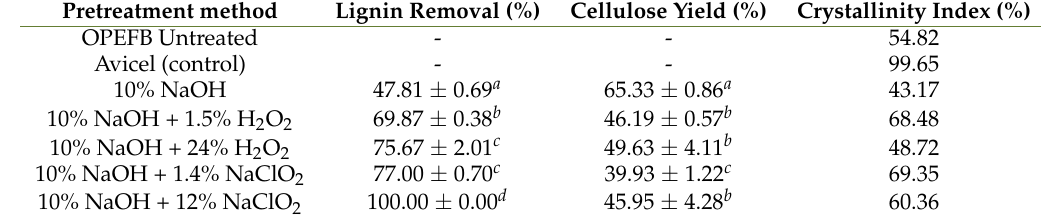
Table 4. The lignin removal, cellulose yield, and crystallinity index of OPEFB after pretreatment process.